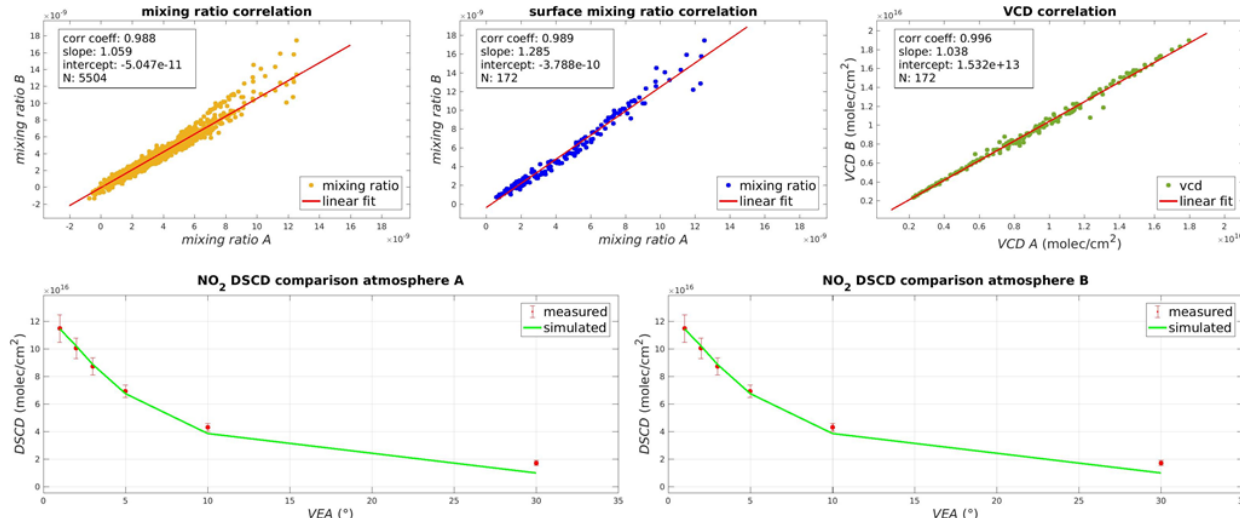
Figure 5. NO 2 retrieval comparison using two different atmospheric profiles: the US standard (atmosphere A) and the US standard adapted to the altitude above sea level of Madrid (atmosphere B). The comparison was carried out for a clear sky day (11 May 2019), considered as representative of the measurement period.